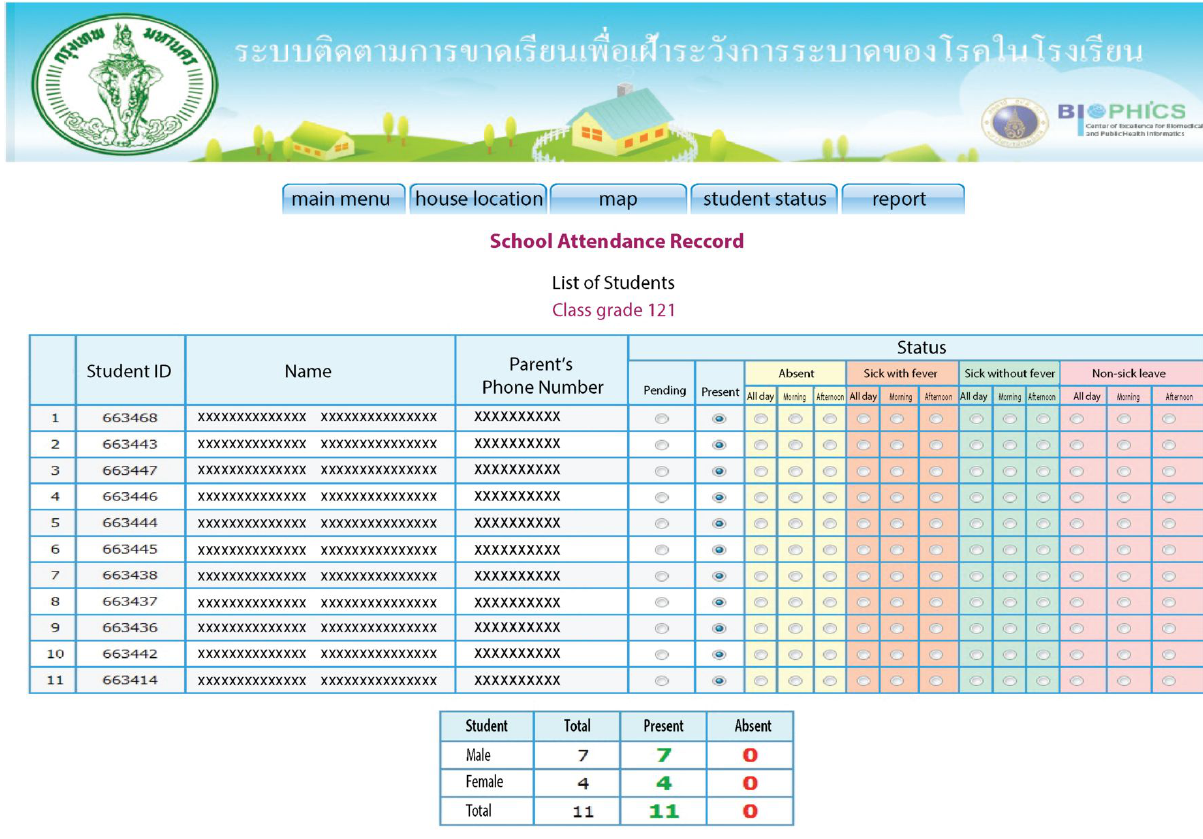
Figure 4. Web page for entering data of the school absenteeism reporting